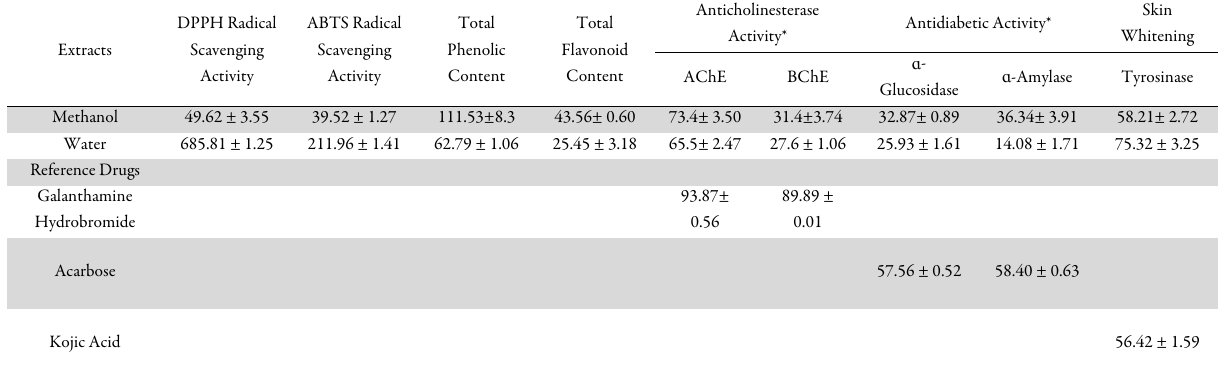
Table 2. In vitro antioxidant and enzyme inhibitory activities (%) of the methanol and water extracts from aerial parts of S. libanotica